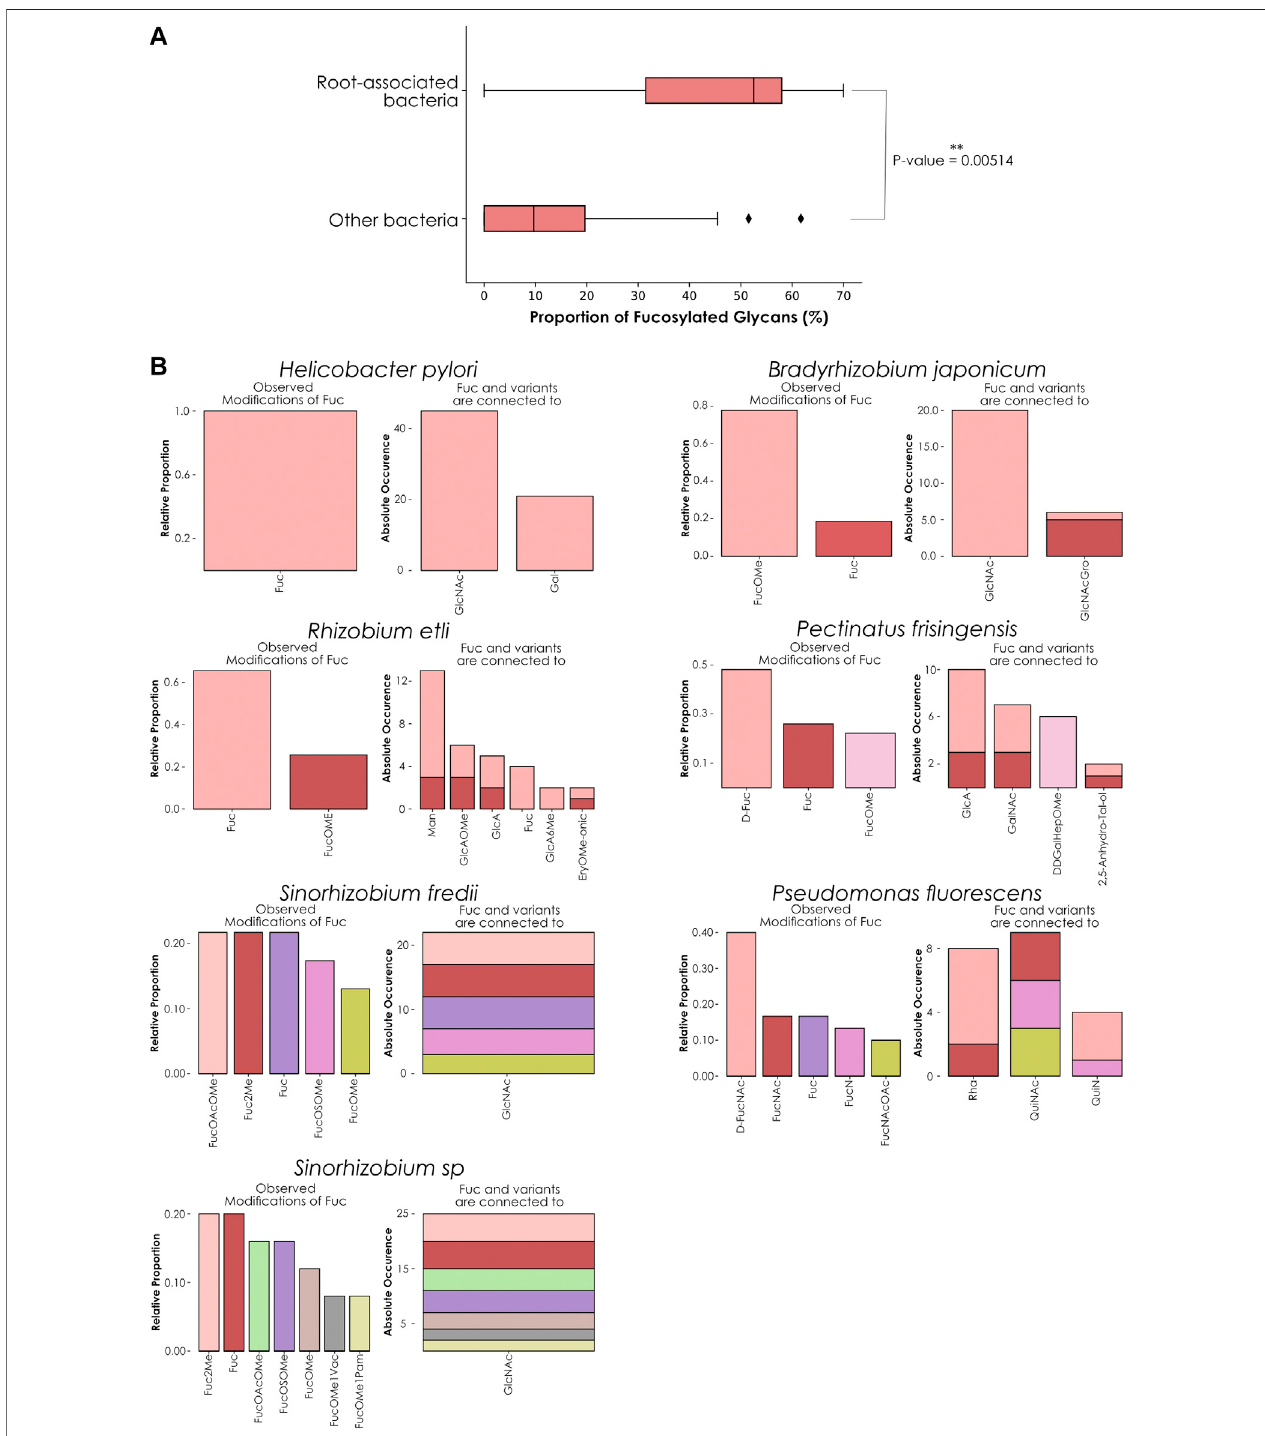
FIGURE 4 | Fucose distribution and usage in glycans among high-fucose content bacterial species. (A) Comparing fucose content across bacterial glycans. This boxplot represents the percentage of fucose-containing glycans from root-associated bacterial species (top) versus all other bacteria (bottom) . Only bacteria that contain at least 30 glycans in our dataset are displayed. The displayed p -value was computed with a one-tailed Welch ’ s t -test. (B) Preferred neighbors of fucose in glycans from high-fucose content bacteria. Each graph represents the relative abundance of fucose and fucose variants. Colored stacked bars correspond to the occurrence of the preferred neighbors of fucose variants in glycans, with colors corresponding to the variants observed on the left part of each graph.